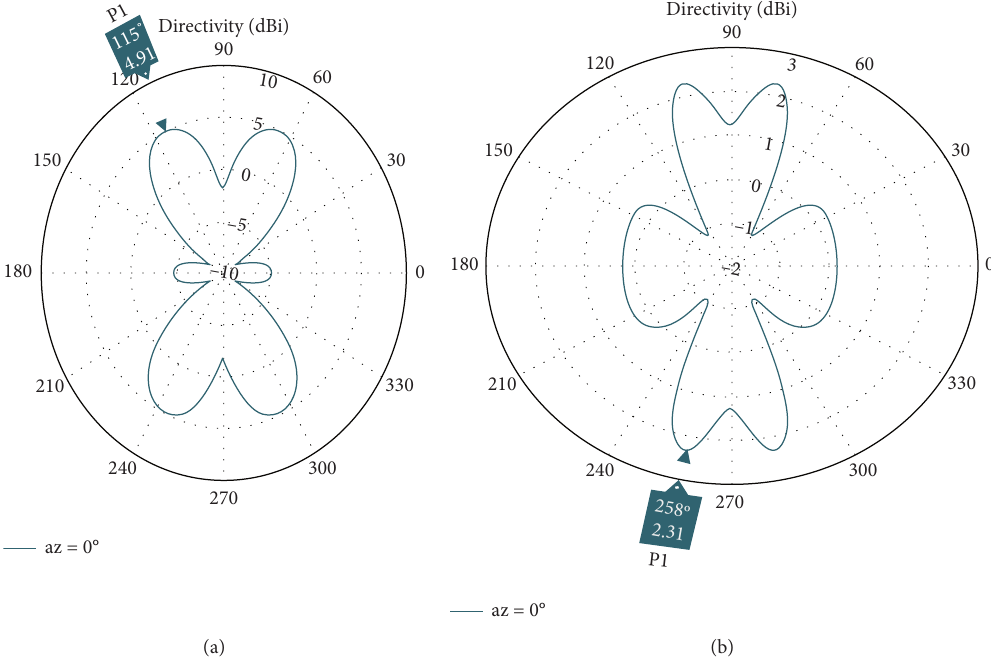
Figure 6: Two-iteration fractal Koch antenna 360 degrees directivity (more precisely, two-iteration Koch’s curve at 460MHz left and right at 770MHz).